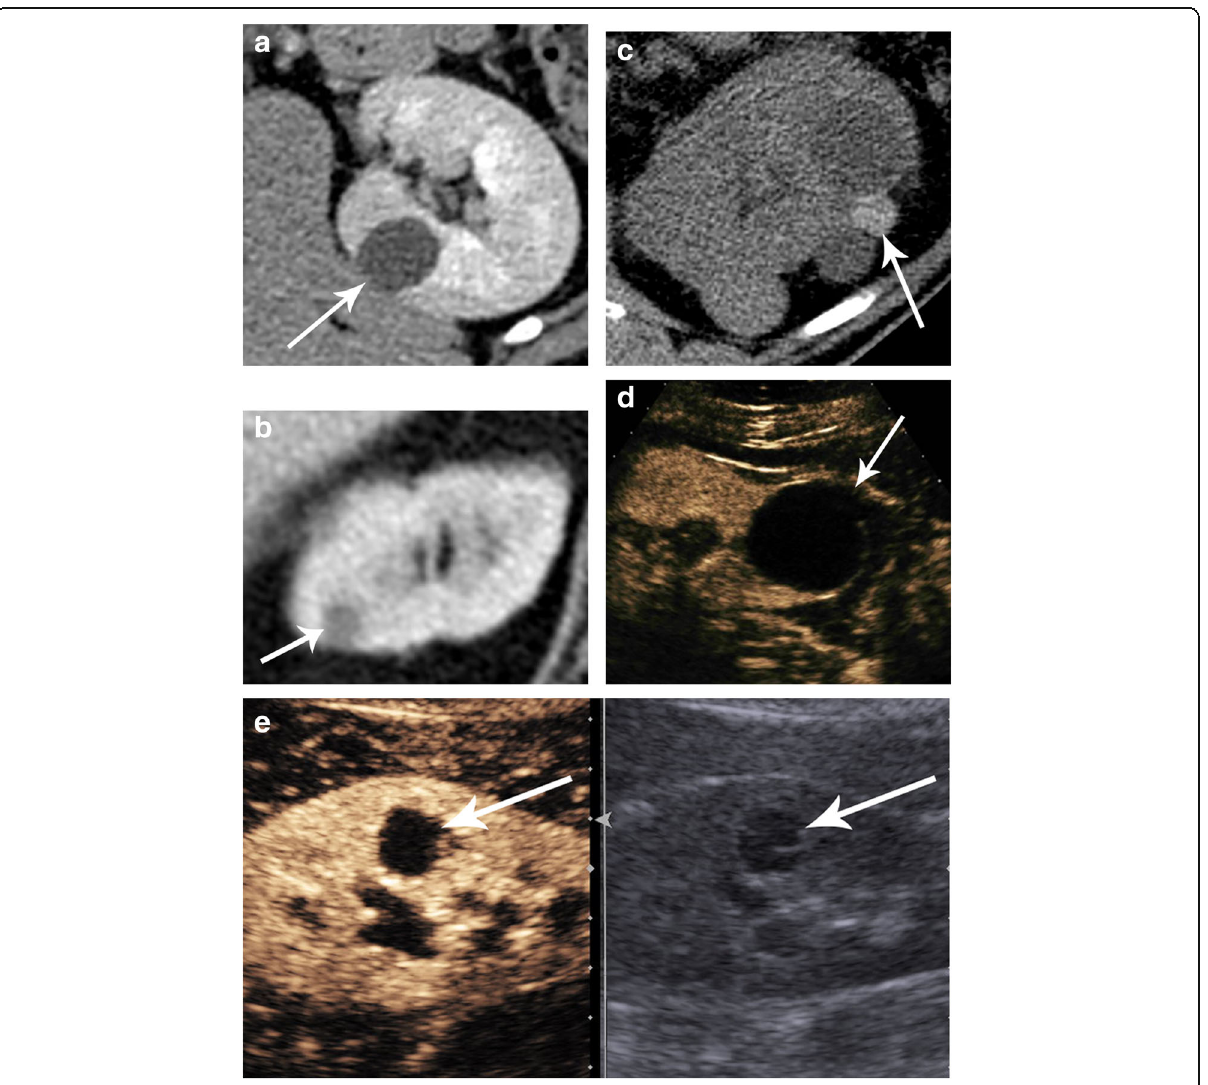
Fig. 3 Renal masses that do not need to be followed. a Axial contrast-enhanced CT showing a right renal too small to characterize mass (TSTC) (arrow); the renal mass is 8 mm in size, and the CT slice thickness is 5 mm, making the renal mass size less than twice the reconstructed CT thickness (8 mm/10 mm). b Axial contrast-enhanced CT showing a hypodense left kidney lesion measuring 3 HU (less than 20 HU), which is likely a simple cyst (arrow). c Axial non-enhanced CT showing a hyperdense left kidney cyst with an attenuation value of 85 HU greater than 70 HU, consistent with a hemorrhagic cyst (arrow). d Contrast-enhanced US of a Bosniak I cystic lesion showing no wall thickening or septa (arrow). e Unenhanced (right) and contrast-enhanced (left) US of a renal Bosniak II cystic lesion with thin septa that did not enhance in the post-contrast study